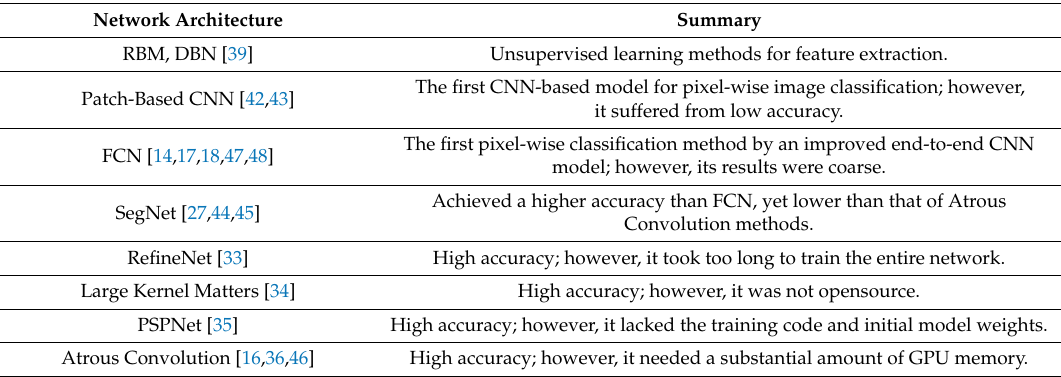
Table 1. A summary of related work.